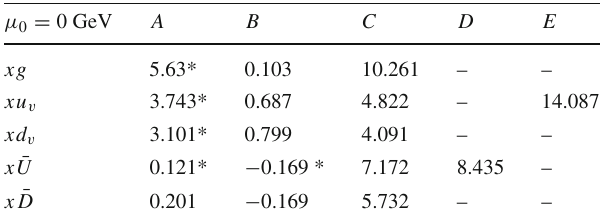
Table 2 Parameters of the input parton distribution at the starting scale = 1 . 9Gev 2 using in the fit all data with Q 2 > 2GeV 2 and without μ 2 F changing the running of the coupling ( μ 0 = 0). Full diffractive cor-